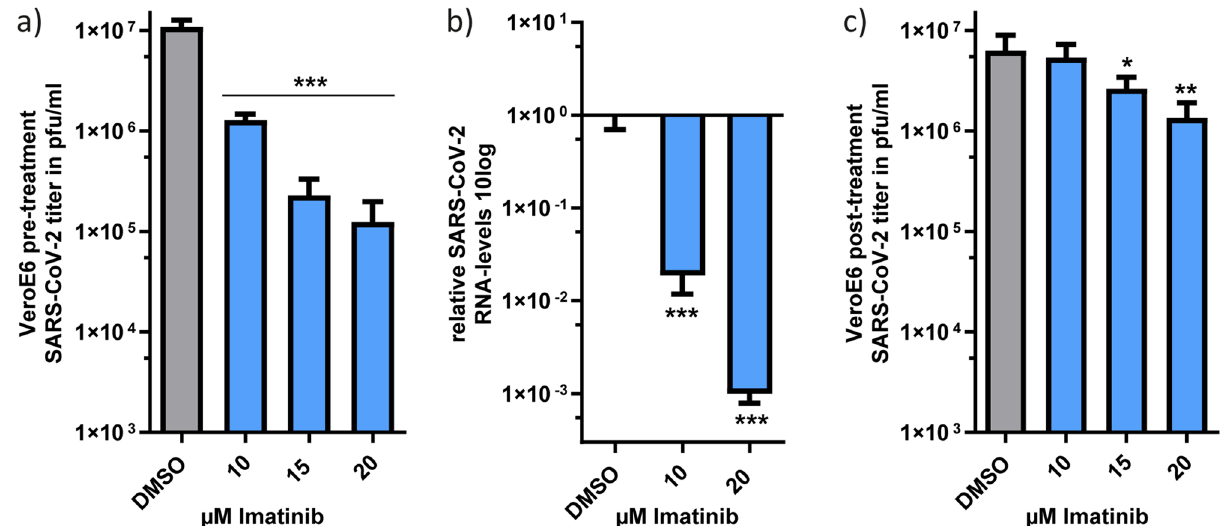
Figure 1. Imatinib diminished SARS-CoV-2 infection in VeroE6 cells. ( a ) Pre-treatment of imatinib reduced SARS-CoV-2 infection. Vero E6 cells were pretreated with increasing concentration of imatinib 2 h prior to infection with SARS-CoV-2 at 0.01 MOI, followed by 24 h incubation. The infectious virions were quantified by viral titration. Results represent one of three biological replicates. ( b ) Imatinib treatment strongly reduced SARS-CoV-2-RNA-levels within the infected cells. VeroE6 cells were imatinib treated and 2 h later infected with SARS-CoV-2. At 24 h, cells were harvested for RNA extraction. The level of viral RNA was quantified by real-time PCR and normalized to βActin RNA level. Results represent three technical replicates. ( c ) Imatinib treatment before SARS-CoV-2 infection is more effective than after infection. VeroE6 cells were infected with SARS-CoV-2 at 0.01 MOI and 2 h later treated with imatinib for 48 h. Results represent four technical replicates. In panels ( a ) to ( c ) data were statistically evaluated with One-Way ANOVA and Dunnett posttest. The data are normalized for the imatinib toxic effects according to XTT results of Fig. S1. * p ≤ 0.05; ** p ≤ 0.01; *** p ≤